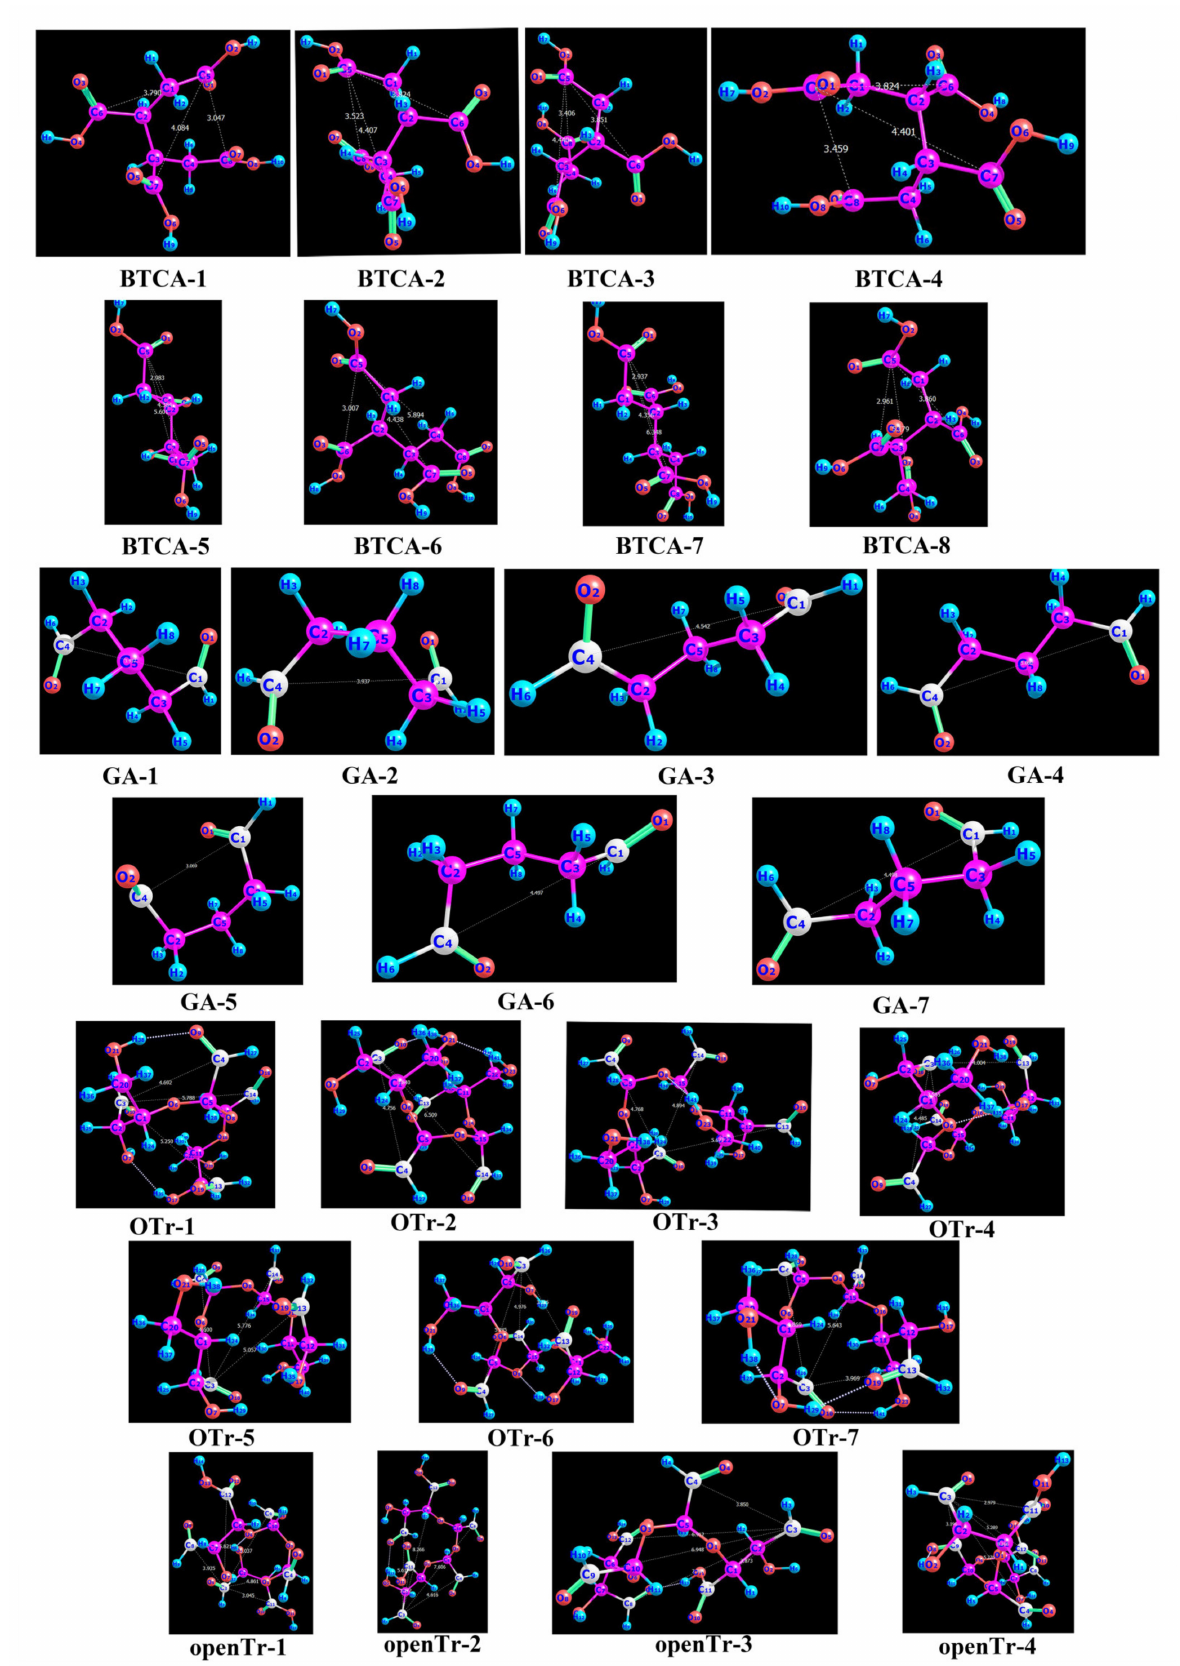
Figure 8. Molecular structure in different conformations and the distance between two cross-linking